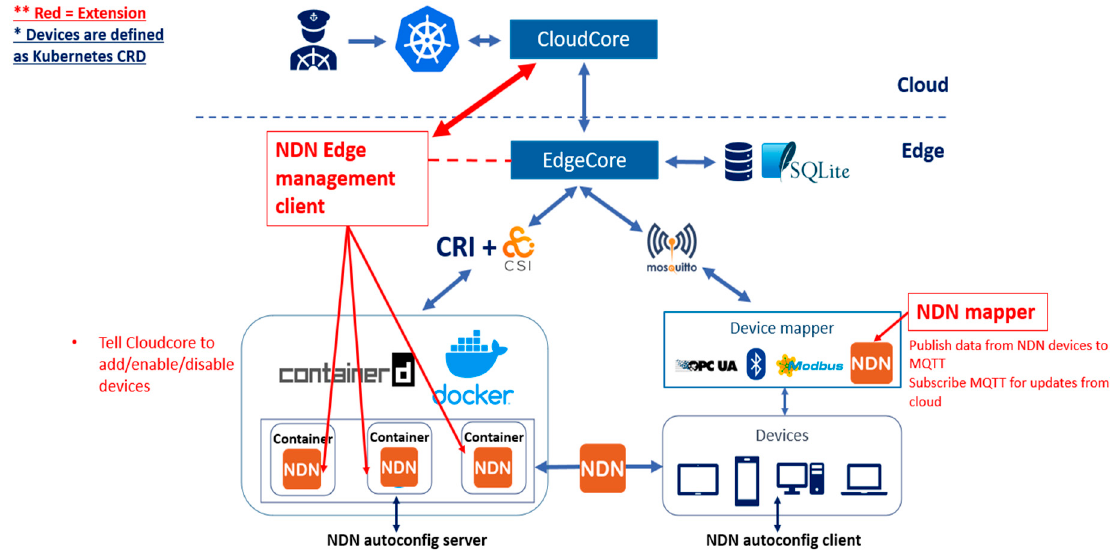
Figure 11. KubeEdge extension to support NDN device management.